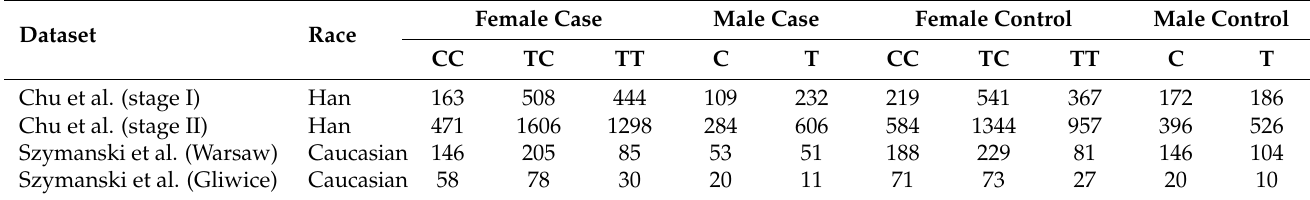
Table 3. Data of rs3827400 related to Graves’ disease in two independent